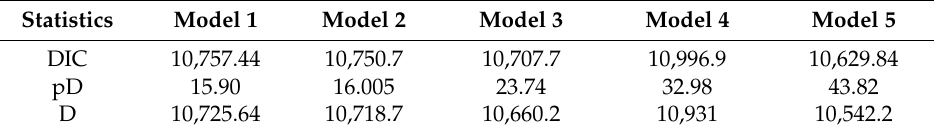
Table 2. Model comparison based on Deviance Information Criteria (DIC).